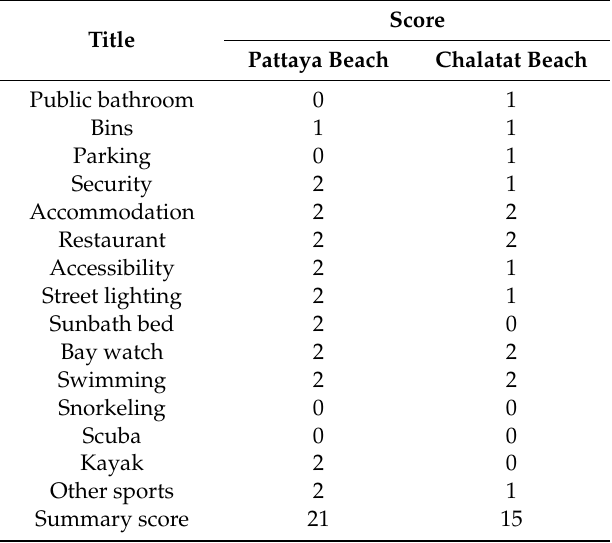
Table 4. Management